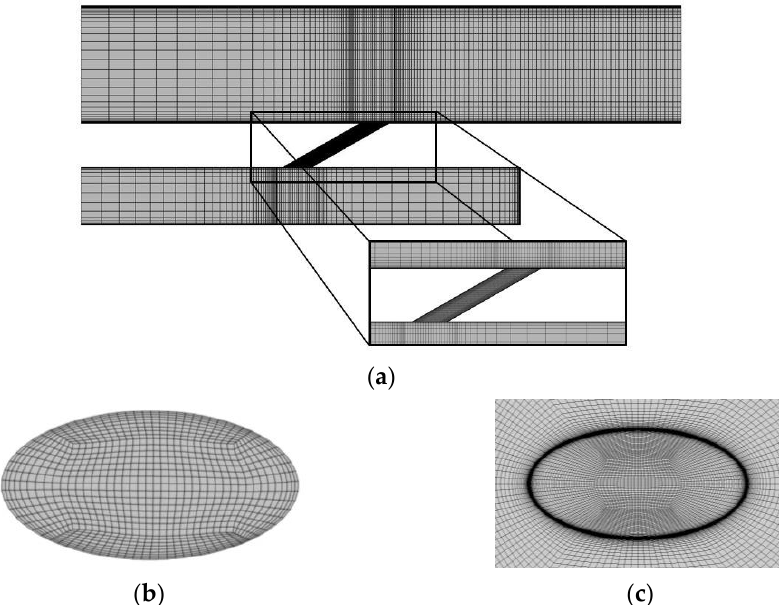
Figure 4. Grid structure and determinant value: ( a ) mesh structure of geometry, ( b ) CH grids of Lee and Kim [9], ( c ) CH grids of present